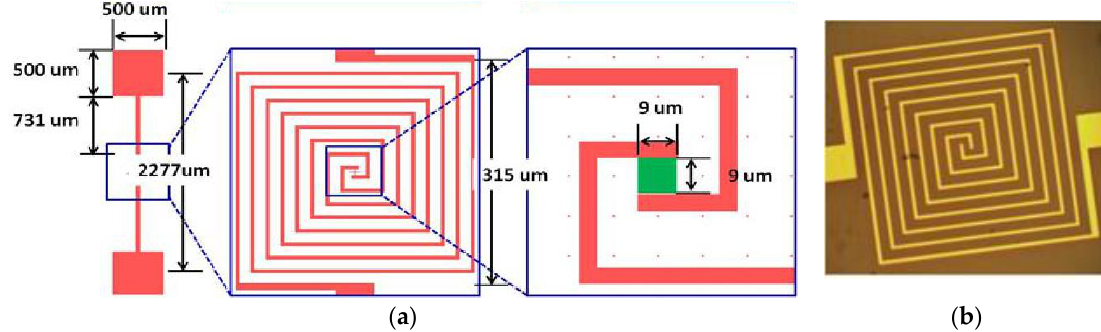
Figure 2. ( a ) Square spiral-antenna design, ( b ) fabricated square spiral antenna with photoconductive gap at the center.